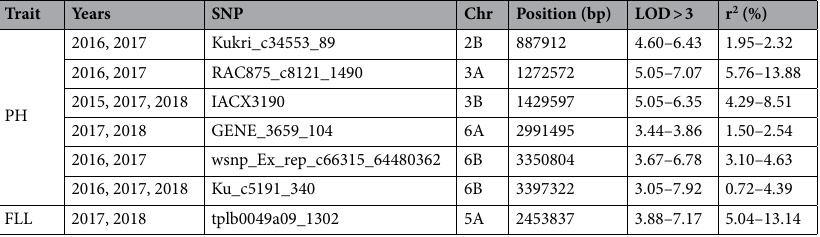
Table 2. Stable SNPs co-detected in multiple environments associated with plant height and flag leaf length. PH (plant height); FLL (flag leaf length). r 2 (%) represents proportion of total phenotypic variation explained by each